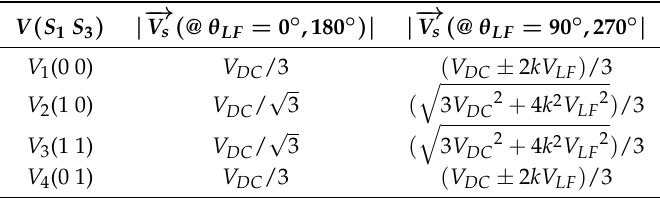
Table 2. Non-zero voltage vectors of FSTP inverter with DC-link fluctuations under LF signal injection at 0 ◦ , 90 ◦ , 180 ◦ , and 270 ◦